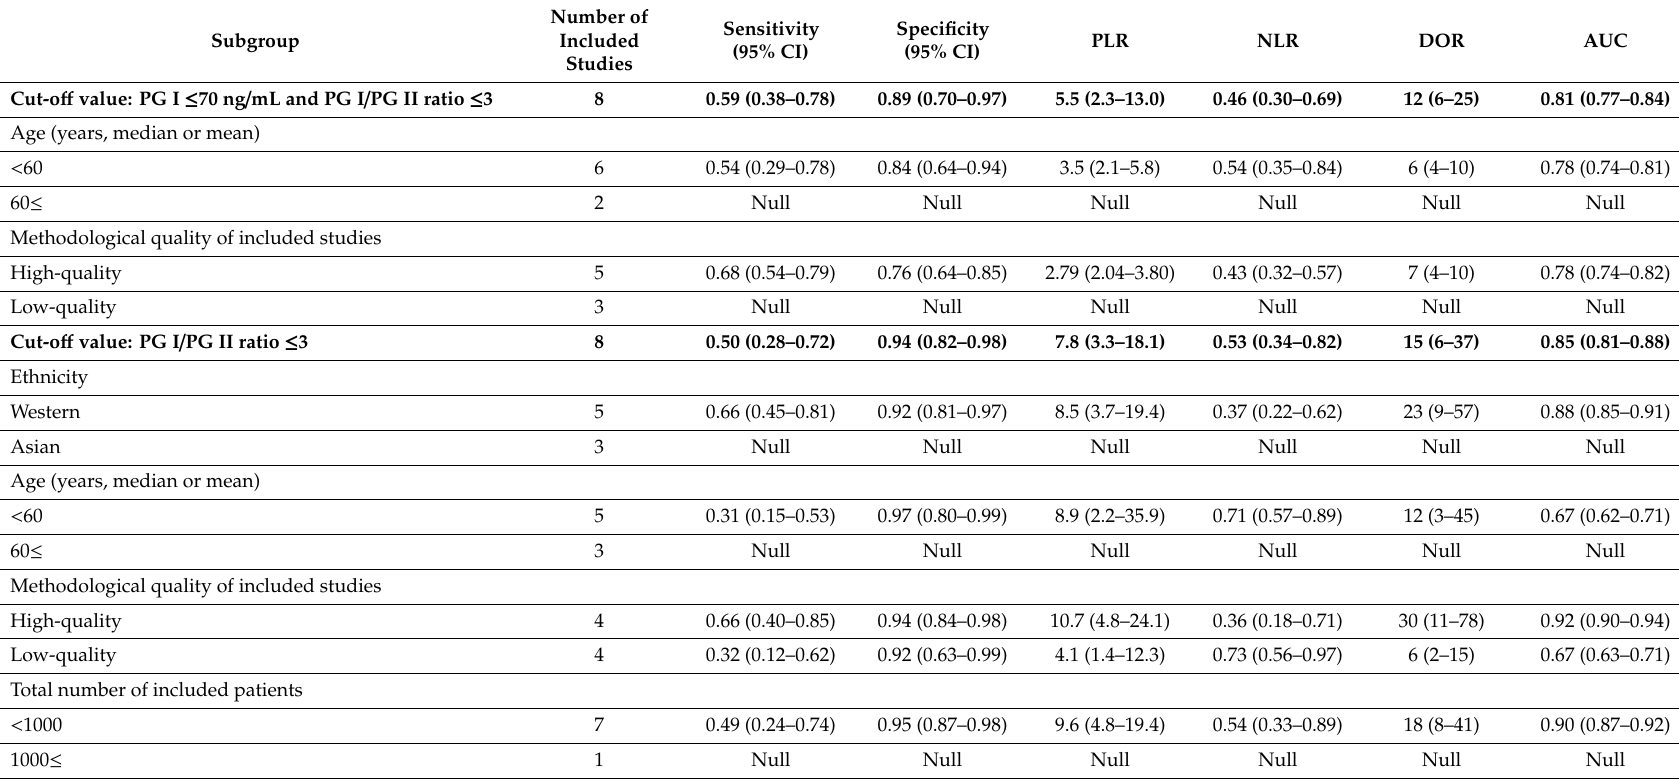
Table 5. Summary of DTA and subgroup analysis of the included studies for the diagnosis of